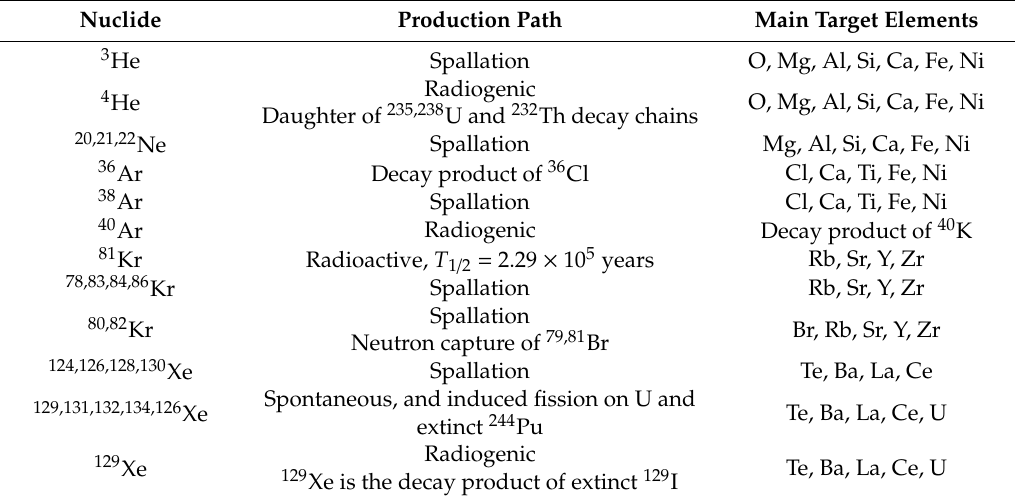
Table 1. Noble gases production in extraterrestrial